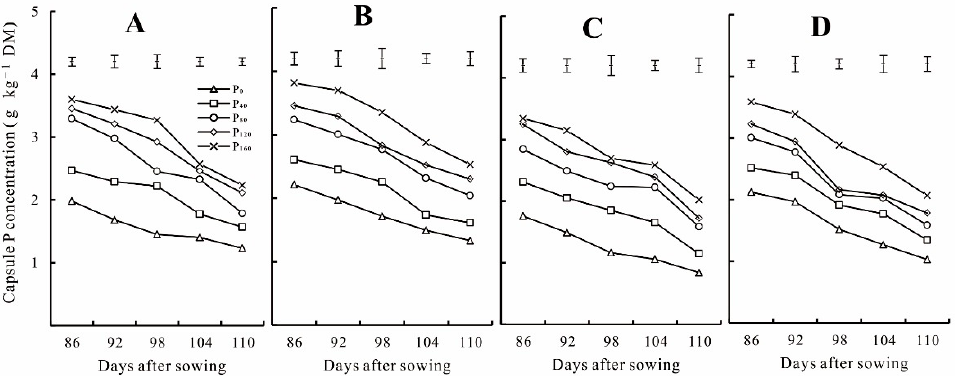
Figure 3. Changes in phosphorus concentration of the capsule for two flax cultivars at five P levels in two growing seasons. ( A ) Lonyaza 1 in 2018; ( B ) Longya 14 in 2018; ( C ) Lonyaza 1 in 2019 and ( D ) Longya 14 in 2019, respectively. The vertical bars indicate the least significant differences (LSDs) with p ≤ 0.05 among five P levels (n = 3).